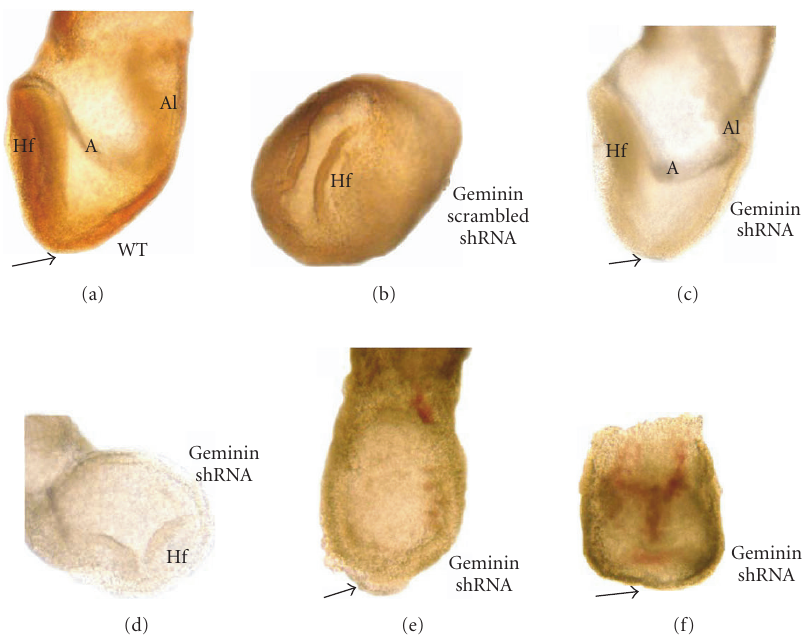
Figure 2: Immunohistochemical localization of geminin in control (a) and (b) embryos, and in embryos exposed on E6.5 to geminin shRNA (c and d). In control embryos, both wild type (a) and embryos exposed on E6.5 to a scrambled geminin hairpin construct (b), the expression of geminin protein was high in the neural ectoderm of the head folds, although geminin was also expressed in the posterior neural ectoderm as well (brown reaction product). There is a slight background staining of the allantois and membranes in all embryos (a)–(d). (c) and (d) Embryos were exposed to the shRNA-targeting geminin, examined and fixed on E7.5 of gestation, then immunohistochemistry to identify patterns of geminin protein expression was carried out as for (a) and (b) (secondary antibody-HRP). There is low-level geminin protein remaining in the neural ectoderm in embryo (c) less than that in embryo (d). (e) and (f) Transmitted light images of embryos exposed to the geminin shRNA on E6.5 and examined on E7.5. (e) Many targeted embryos exhibited axis defects, abnormal expansion of the node (arrow), and in later embryos, the endoderm of the gut tube often failed to close. (f) Occasionally, the embryonic axis appeared very flattened, and there was blood within the amniotic cavity. (a), (c), (e), and (f) are sideviews with anterior located toward the left. (b) is a dorso-lateral view, and (d) is a frontal (coronal) view. A: amnion, Al: allantois, Hf: head folds, WT: wild-type control embryo. Arrows indicate the node.